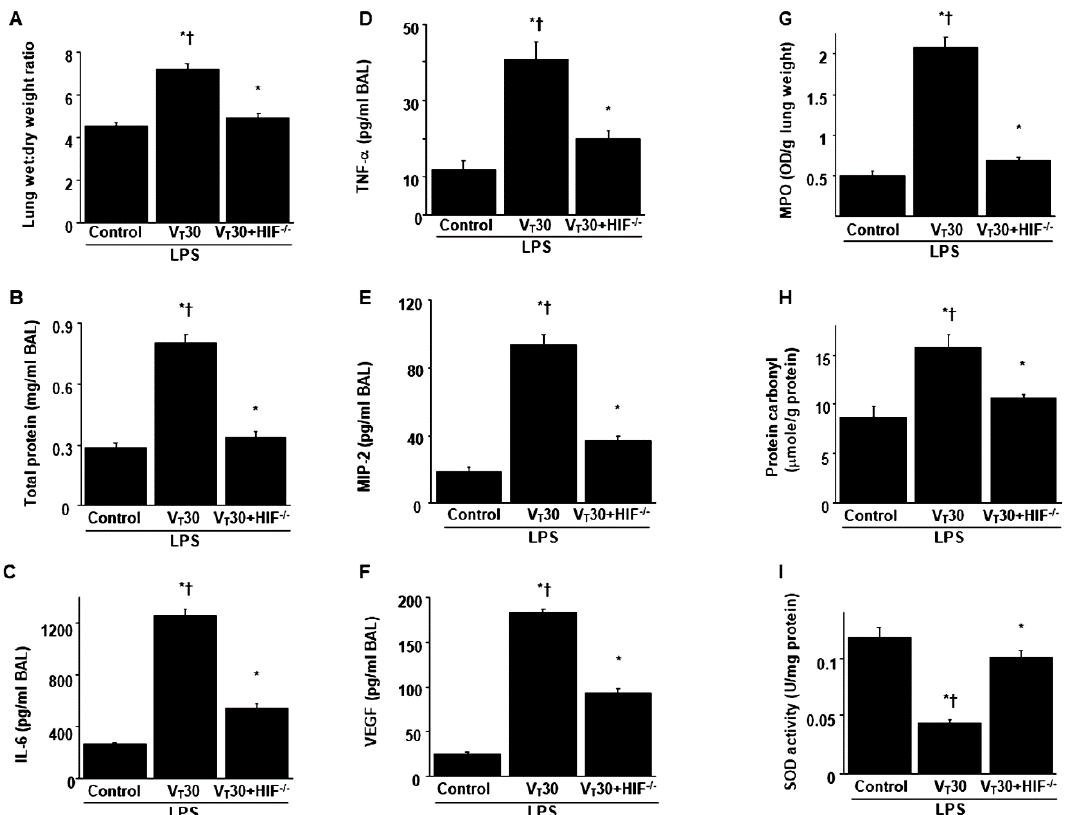
Figure 5. Inhibition of endotoxin-stimulated MV-induced lung injury in HIF-1 α deficient mice. ( A ) Lung wet-to-dry-weight ratio, ( B ) BAL fluid total protein, ( C ) IL-6, ( D ) TNF- α , ( E ) MIP-2 and ( F ) VEGF secretion in BAL fluid, ( G ) MPO activity, ( H ) protein carbonyl groups and ( I ) SOD were from the lungs of nonventilated control mice and those subjected to a tidal volume of 30 mL / kg for 5 h with LPS administration ( n = 5 per group). * p < 0.05 versus the nonventilated control mice with LPS; † p < 0.05 versus HIF-1 α -deficient mice. HIF − / − = hypoxia inducible factor-1 α -deficient mice.